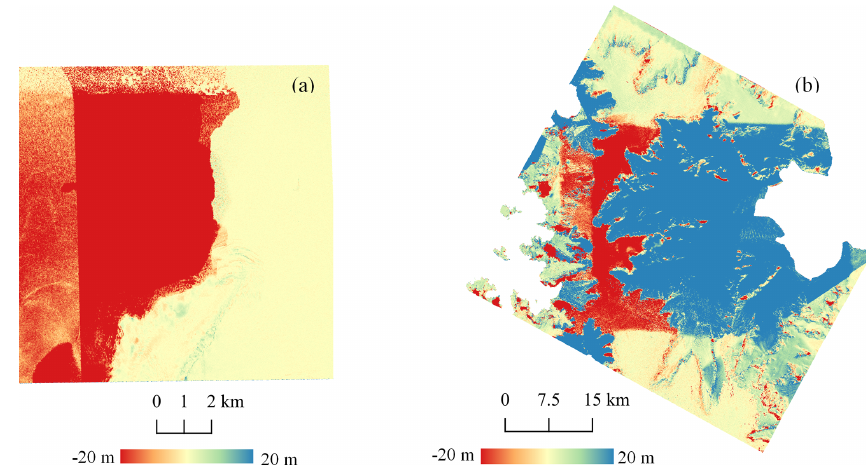
Figure 15. Elevation difference in the fused DEM minus the REMA mosaic in the (a) local sample and (b) HG